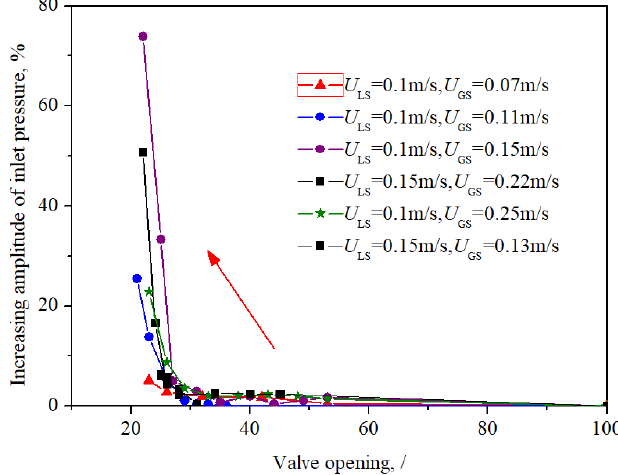
Figure 7. Increasing amplitude of pipeline inlet pressure in the process of choking.